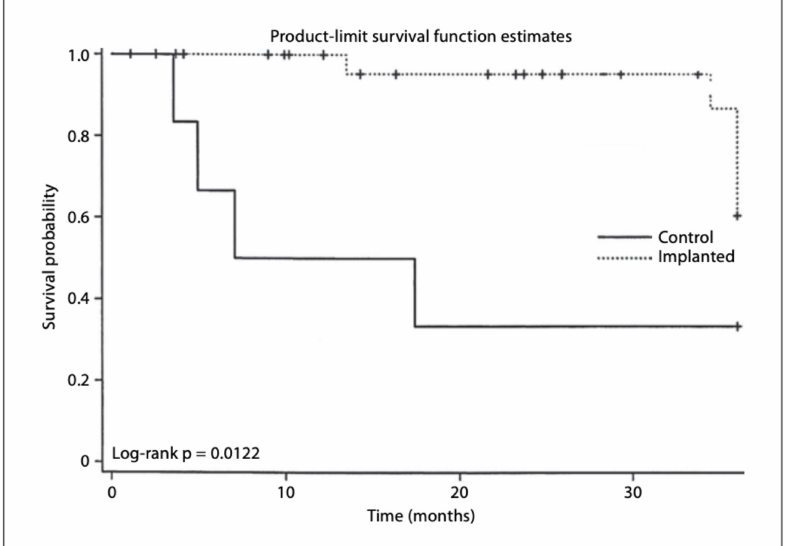
Figure 10. All diabetic implanted versus nonimplanted patients. Survival was lower for diabetic patients not implanted with the GES device